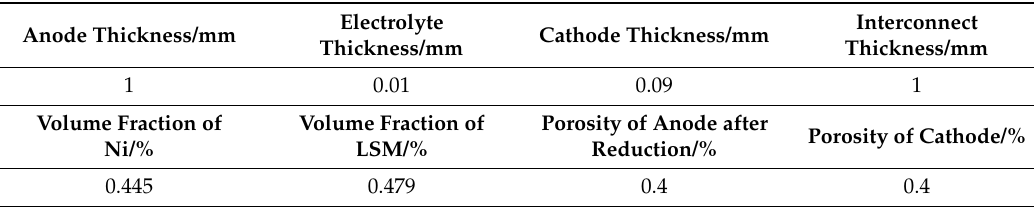
Table 3. Main geometric parameters of the repeating SOFC.